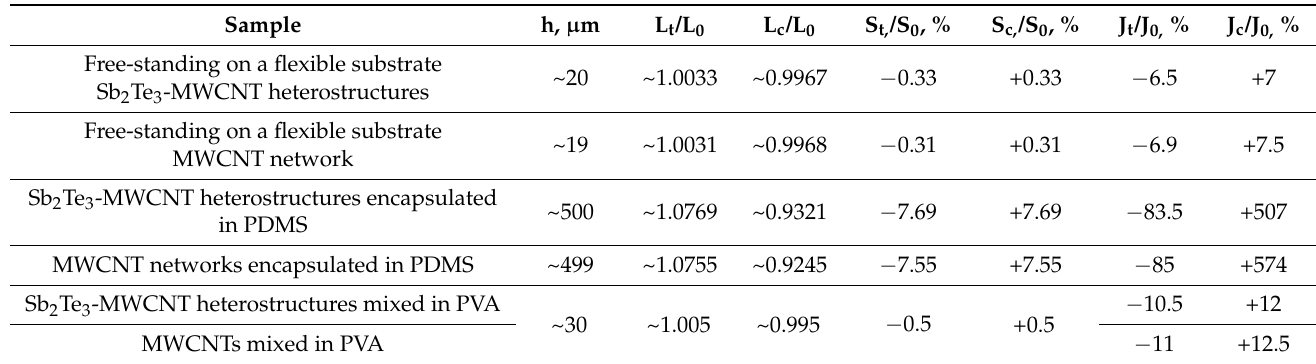
Table 1. Estimated changes in the length of sides (L), areas of direct electrical contacts (S), and tunnel current densities (J) of the polymer-based film subjected to tensile (L t ; S t ; J t ) or compressive (L c ; S c ; J c ) stress relative to the length of the middle line (L 0 ), electrical contact area of not-bent sample (S 0 ) and tunnel current density in not-bent sample (J 0 ) of the film during the thin film bending down to the r c = 3